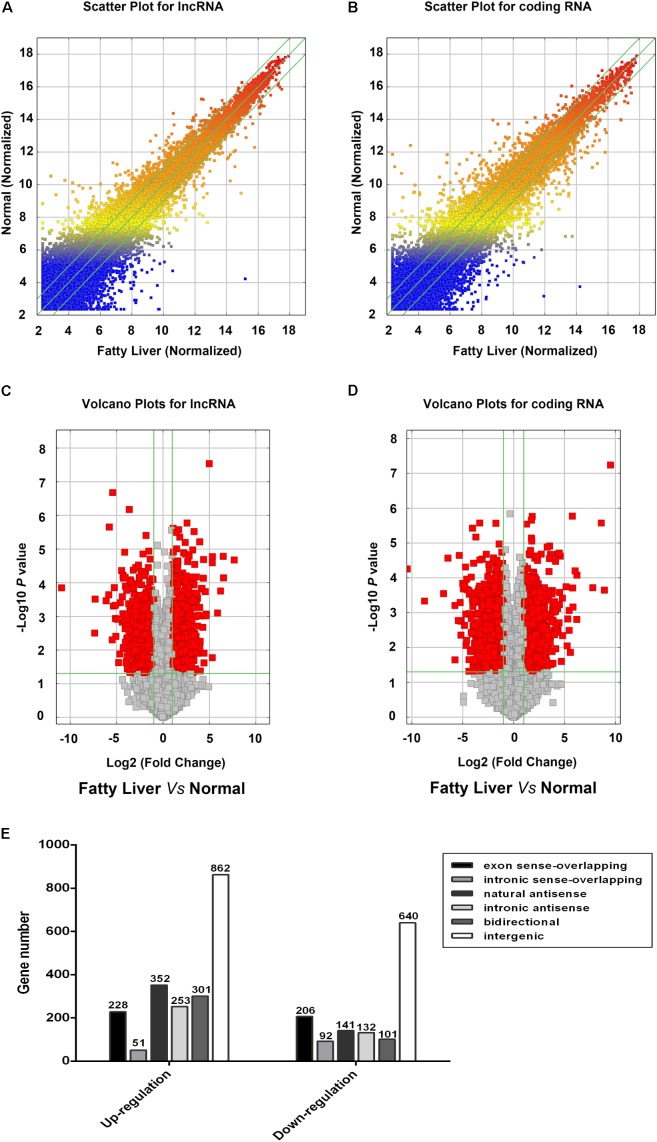
Profiles of lncRNAs and coding gene RNAs in non-alcoholic fatty liver disease (NAFLD) mice and control mice. Total RNA from three db/db mice and three control mice were isolated and gene expression was determined by Mouse LncRNA Microarray V2.0. The scatter plot was used for assessing the reproducibility of long non-coding RNA (lncRNA; A) and coding gene (B) expression. The values on x and y axis in the scatter plot are the averaged normalized signal values of groups of samples (log 2 scaled). Volcano plot analysis of the microarray chip data on differentially expressed lncRNAs (C) and coding gene (D) between the NAFLD and control mice. The vertical green lines correspond to a 2.0-fold up or down regulation whereas the horizontal green line represents a value of 0.05. The red dots to the left and right of the vertical green lines indicate more than 2.0-fold change and represent differential expression with statistical significance. Statistical significance was defined as fold change > 2.0 and p-value < 0.05 between the NAFLD and control groups. (E) Distribution of differentially expressed lncRNAs according to their classification.